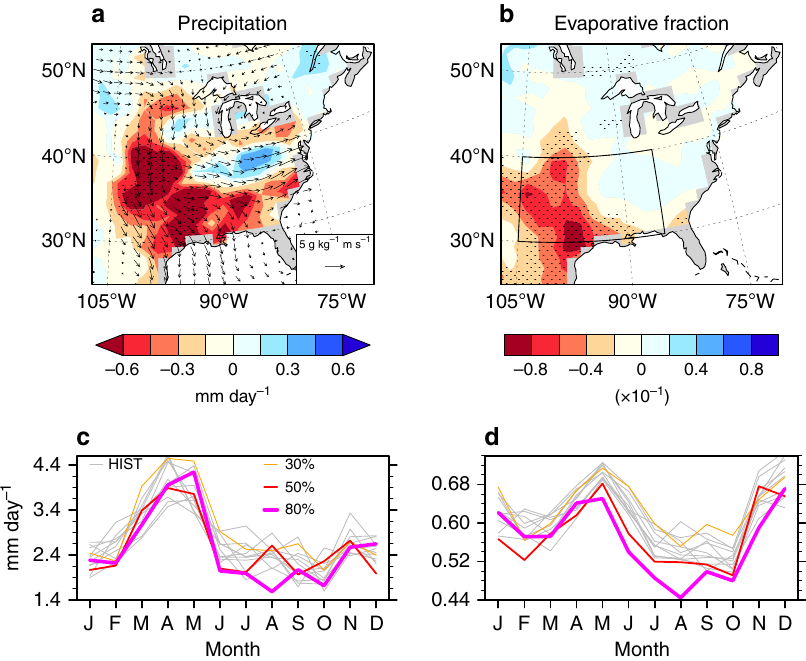
Fig. 4 Late spring conditions prior to the Dust Bowl summers. a , b , Composite differences in April – May conditions between the fi ve-member Atlantic sea surface temperature (SST) ensemble mean (ATL HIST ) and fi ve-member Paci fi c SST ensemble mean (PAC HIST ) prior to the Dust Bowl summers for 1930 – 37. The fi elds shown are precipitation (colours; a ) and 850 hPa moisture fl ux (vectors; a ) and evaporative fraction ( b ). Stippling on precipitation and evaporative fraction contours indicates signi fi cance above the 95% con fi dence level based on a bootstrap mean difference on 10,000 × 8 April – May samples (resampled). c , d Annual cycle of precipitation ( c ) and evaporative fraction ( d ) for the ten-member historical SST members (HIST) and bare-soil model experiments averaged over 1930 – 1937 and the southern – central US (region in ( b ); 105° – 85°W, 30° –